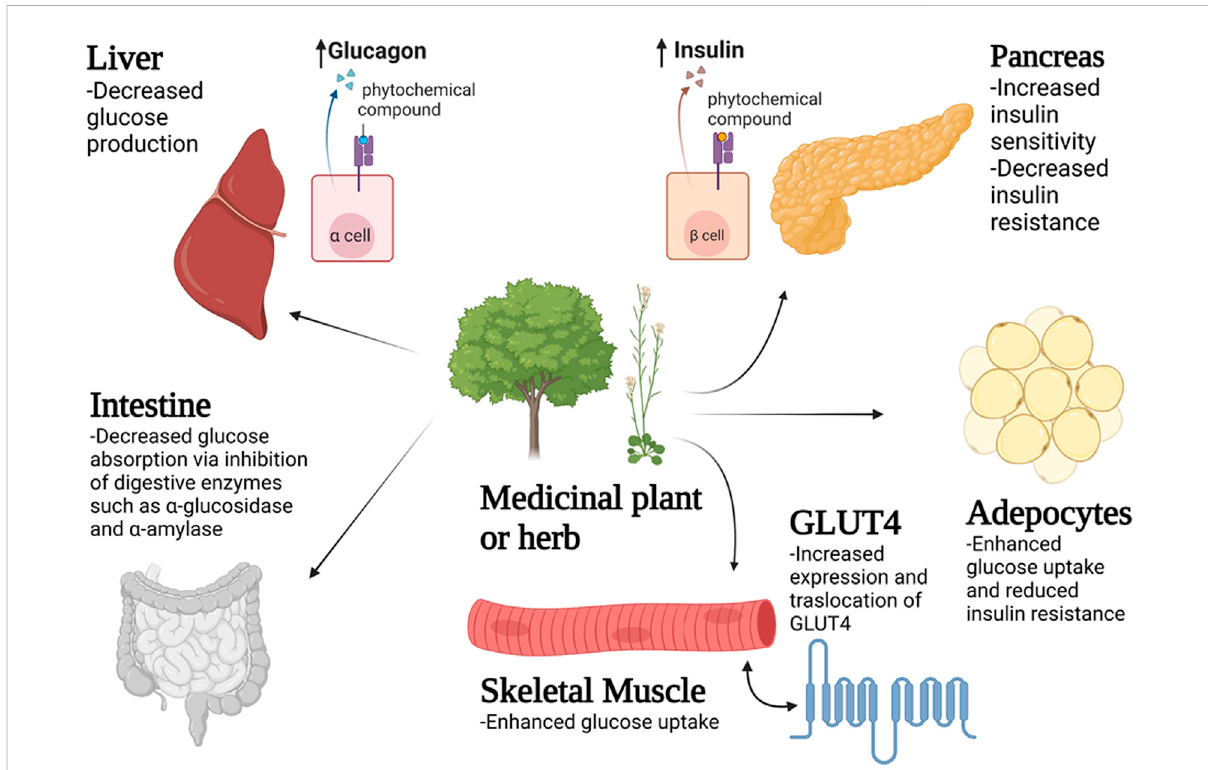
FIGURE 1 The mechanism of decreasing blood glucose levels by medicinal plants and herbs on different tissues and organs such as the liver, intestine, pancreas, skeletal muscle and adipose